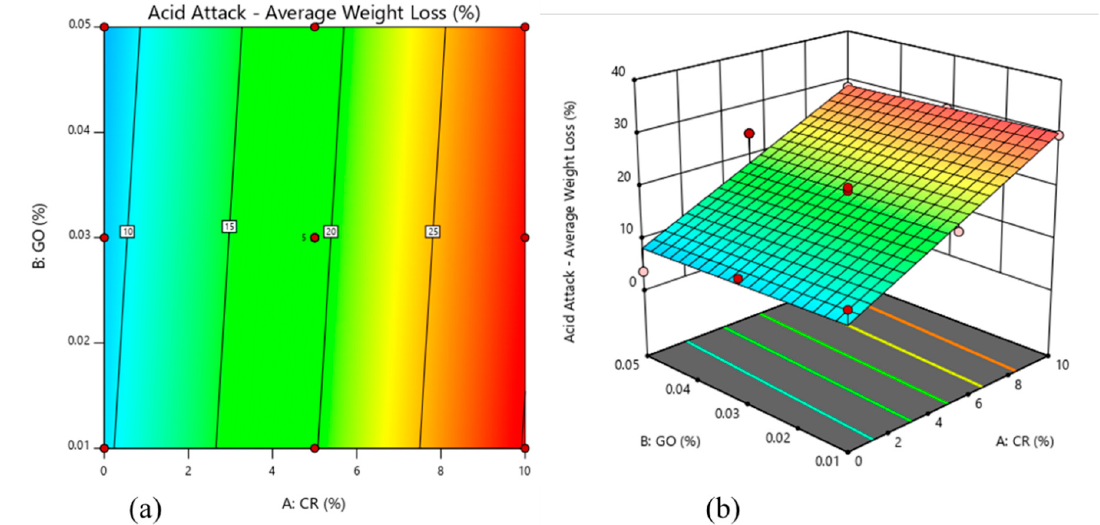
Figure 9. Acid attack of rubberized ECC with GO: ( a ) 2D contour plot and ( b ) 3D surface response.